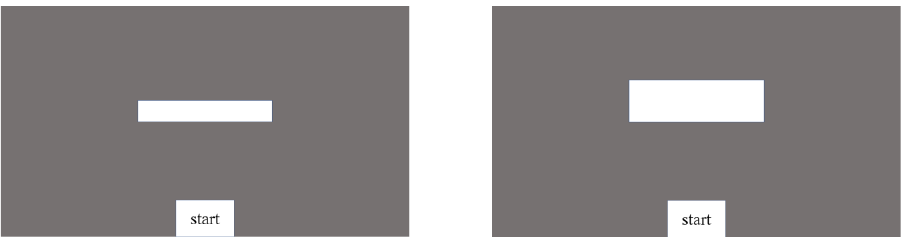
Figure 1. The target used in Experiment 1 was either a small rectangle or a large rectangle. The displays were presented either blocked or alternately. Thus, 4 kinds of movement from the current trial to the next trial were identified: large-to-large (L:L), small-to-small (S:S), small-to-large (S:L), and large-to-small (L:S).